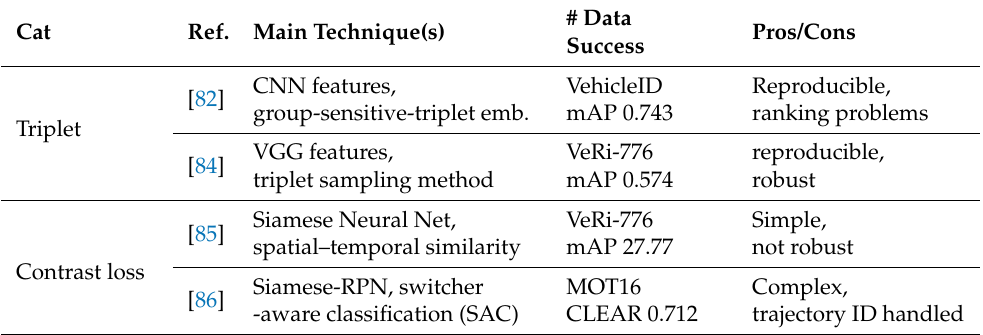
Table 7. Performance evaluation of the reviewed vehicle ReID using deep leaning metric methods.